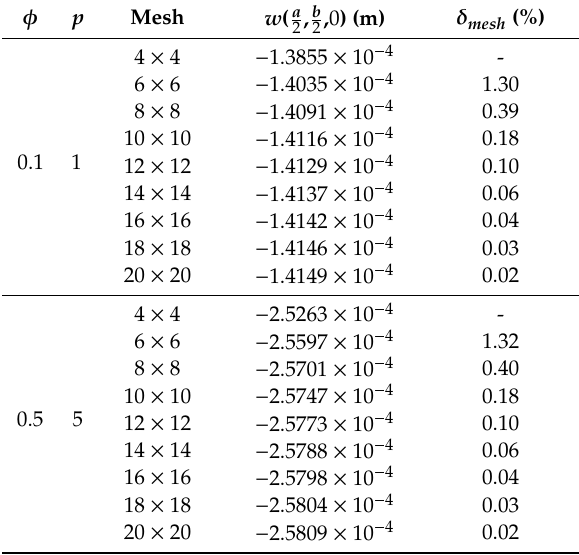
Table 5. Porosity distribution model M1: convergence study.